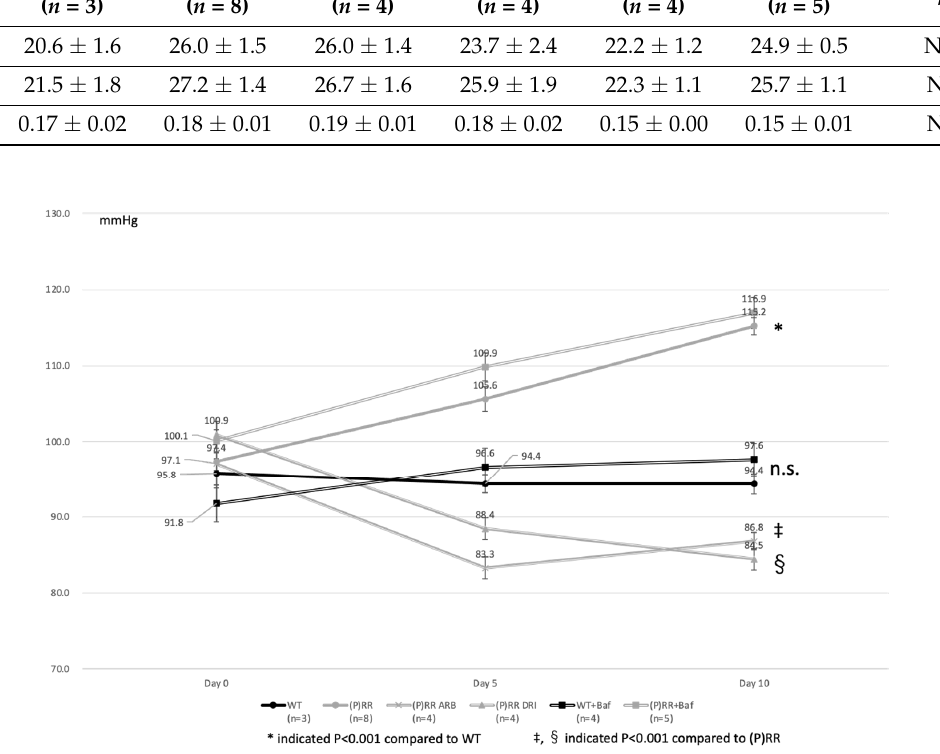
Figure 4. Experimental overview is shown. WT: wild type; (P)RR TG: (P)RR transgenic mice; BW: body weight; WI: water intake; UV: urine volume; ARB: angiotensin receptor blocker; DRI: direct Table 1. Summary of body weight and kidney weight of mice. renin blocker; BP: blood pressure; HR: heart rate. Table 1. Summary of body weight and kidney weight of mice.